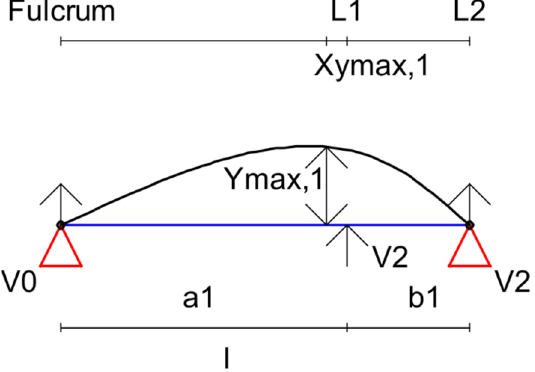
Figure A5. Representation of the hyperstatic beam without the force F.